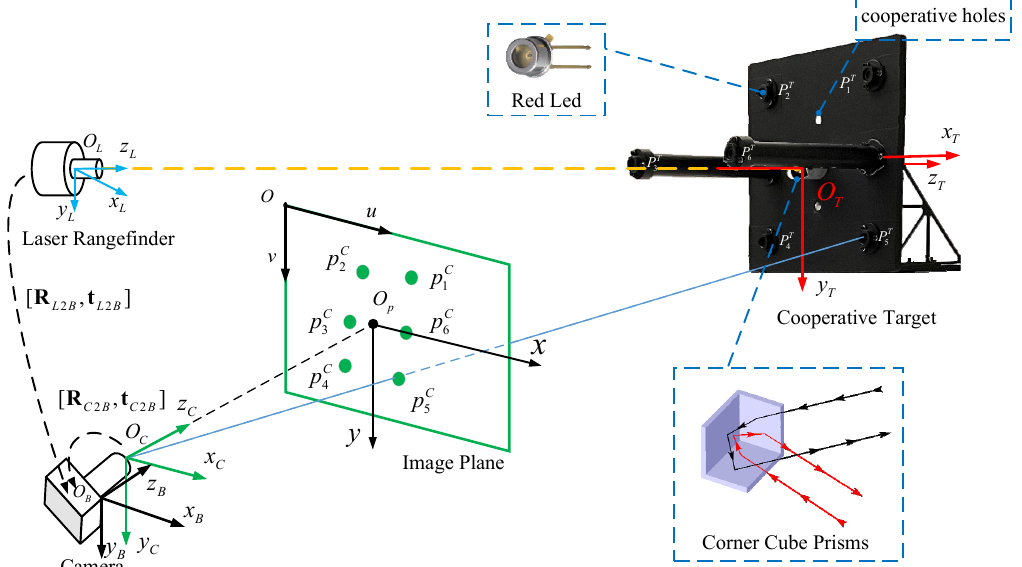
Figure 2. Sketch map of the proposed method based on fusion of a monocular camera and an LRF. Our cooperative target consists of a laser corner cube prism and six red LEDs. Four LEDs are placed on the front panel of the target in a square configuration with a width of approximately 200 mm. The remaining two LEDs are placed on two slender rods whose length is approximately 200 mm. The laser corner cube prism is placed on the diagonal of the four LEDs. The relative positions of the six LEDs and corner cube prism are strictly calibrated using a three-coordinate measuring machine. The corner cube prism is used to reflect the laser, which ensures a laser distance measurement with ultra-high